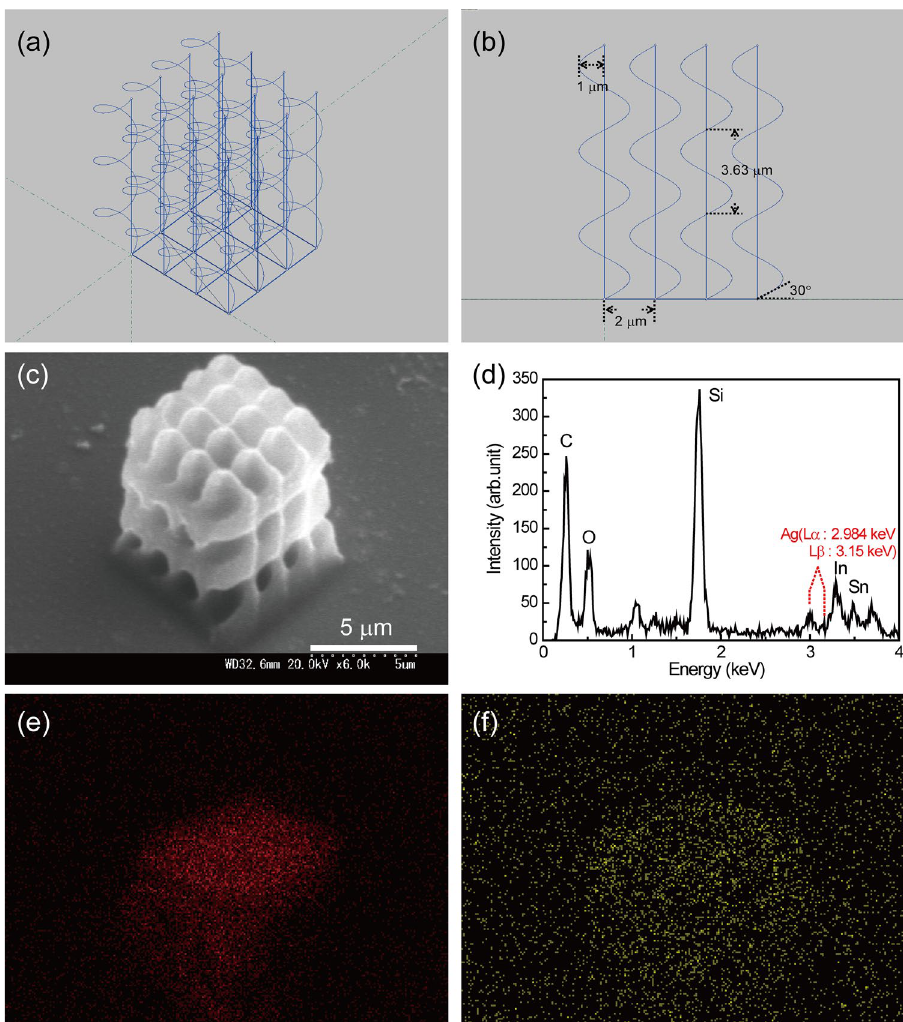
( d ) EDX spectrum of the fabricated structure with silver plating. ( e ) EDX image of C in the fabricated helical structure with silver plating. ( f ) EDX image of Ag in the fabricated helical structure with silver